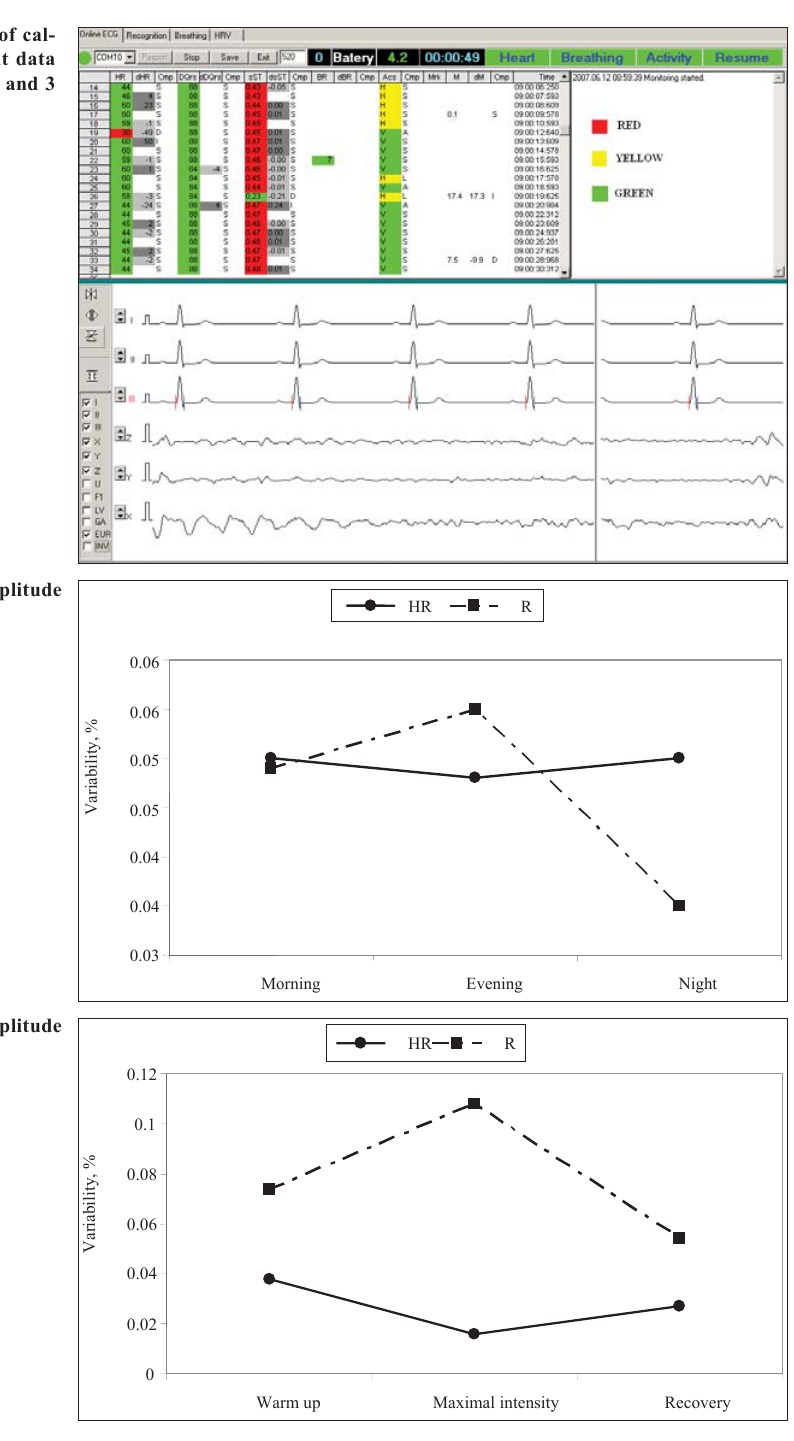
indicated by different colors: green — normal,